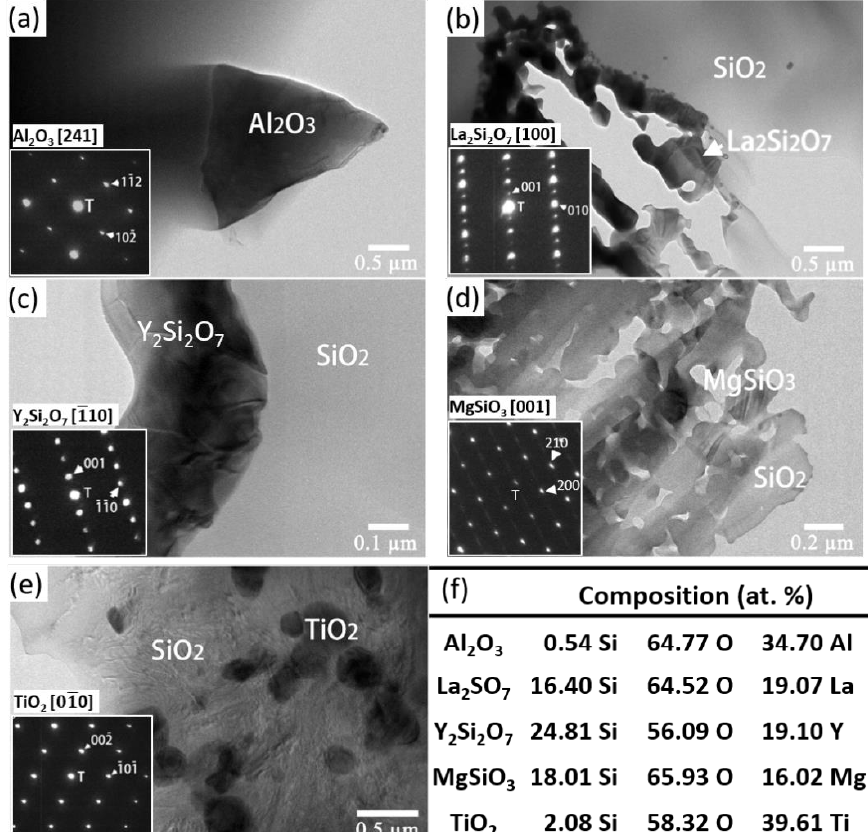
Figure 5. ( a – e ) BFIs/TEM images and inserted SADP of Si–10 wt.% Al 2 O 3 , La 2 O 3 , Y 2 O 3 , MgO, and TiO 2 interfaces after sintering at 1300 °C in Ar, respectively. ( f ) EDS summary of reaction phases (La 2 Si 2 O 7 , Y 2 Si 2 O 7 , and MgSiO 3 ) and ceramic additives (Al 2 O 3 and TiO 2 ) in SiO 2 .